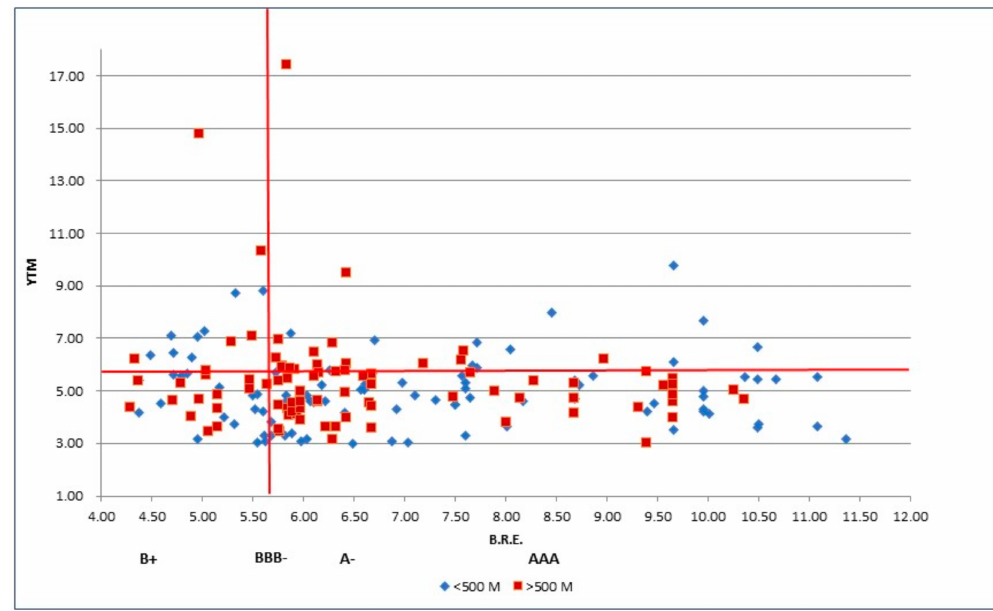
Figure 2. Return/Risk Tradeoffs— Distressed & High-Yield Bonds. BRE: bond rating